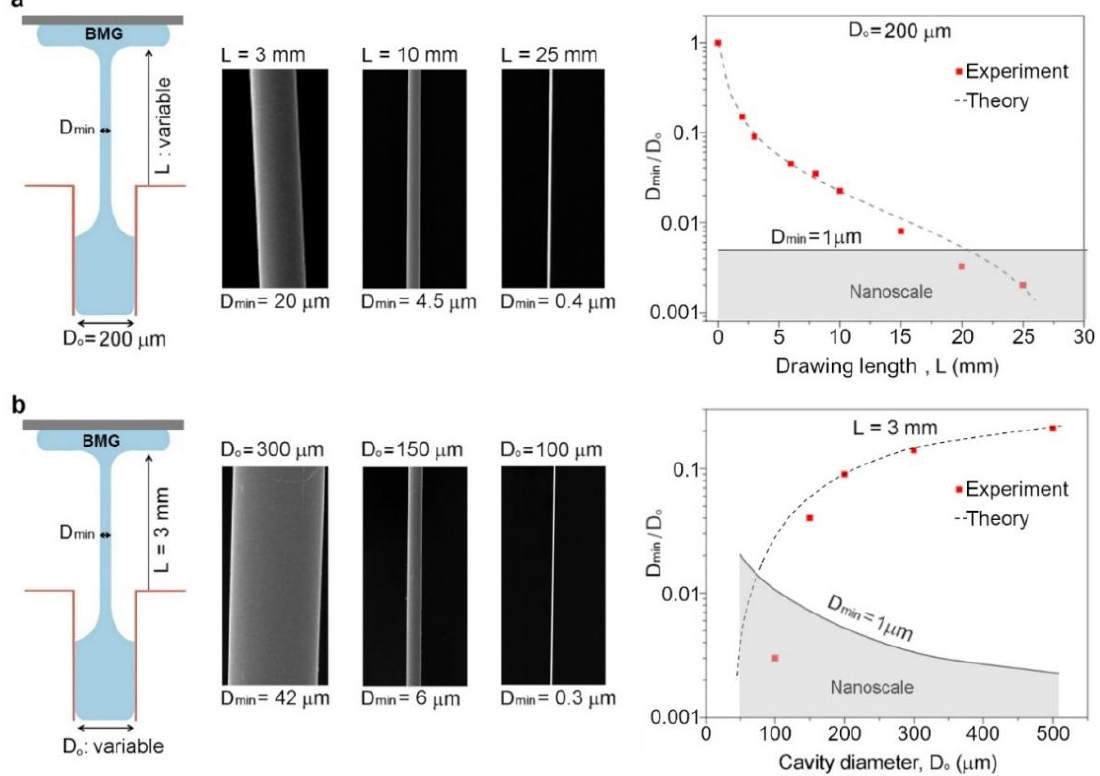
Figure 4. Dependence of minimum fiber diameter ( D min ) on elongation ( L ) and cavity diameter ( D o ) during thermoplastic drawing. ( a ) D min / D o as a function of L and ( b ) D min / D o as a function of D o for Pt-based BMG drawn at 270 °C and velocity of 10 mm/min. The experimental values are compared with the theoretical predictions based on Equation (2). SEM images of selected samples for variable L and D o are also shown.